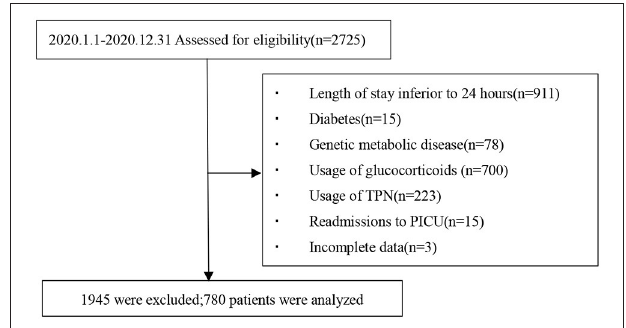
FIGURE 1 | Flowchart illustrating the inclusion and exclusion of participants for the study.